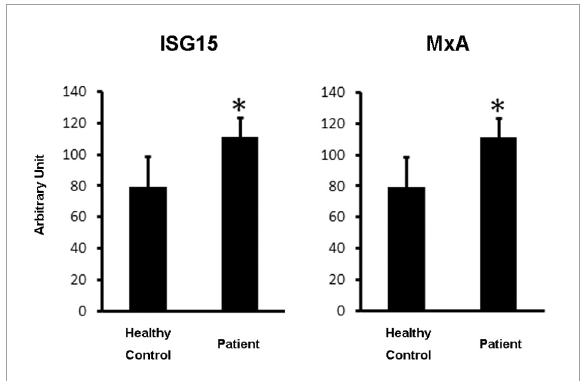
FIGURE4 A cell-based type-I IFN assay. HepG2 cells were stimulated with the patient’s serum and healthy control serum at 10% concentration for 18 h ( N = 3). The cDNA was amplified separately. Error bars indicate standard deviations. Statistical significance ( p < 0.05) is indicated by